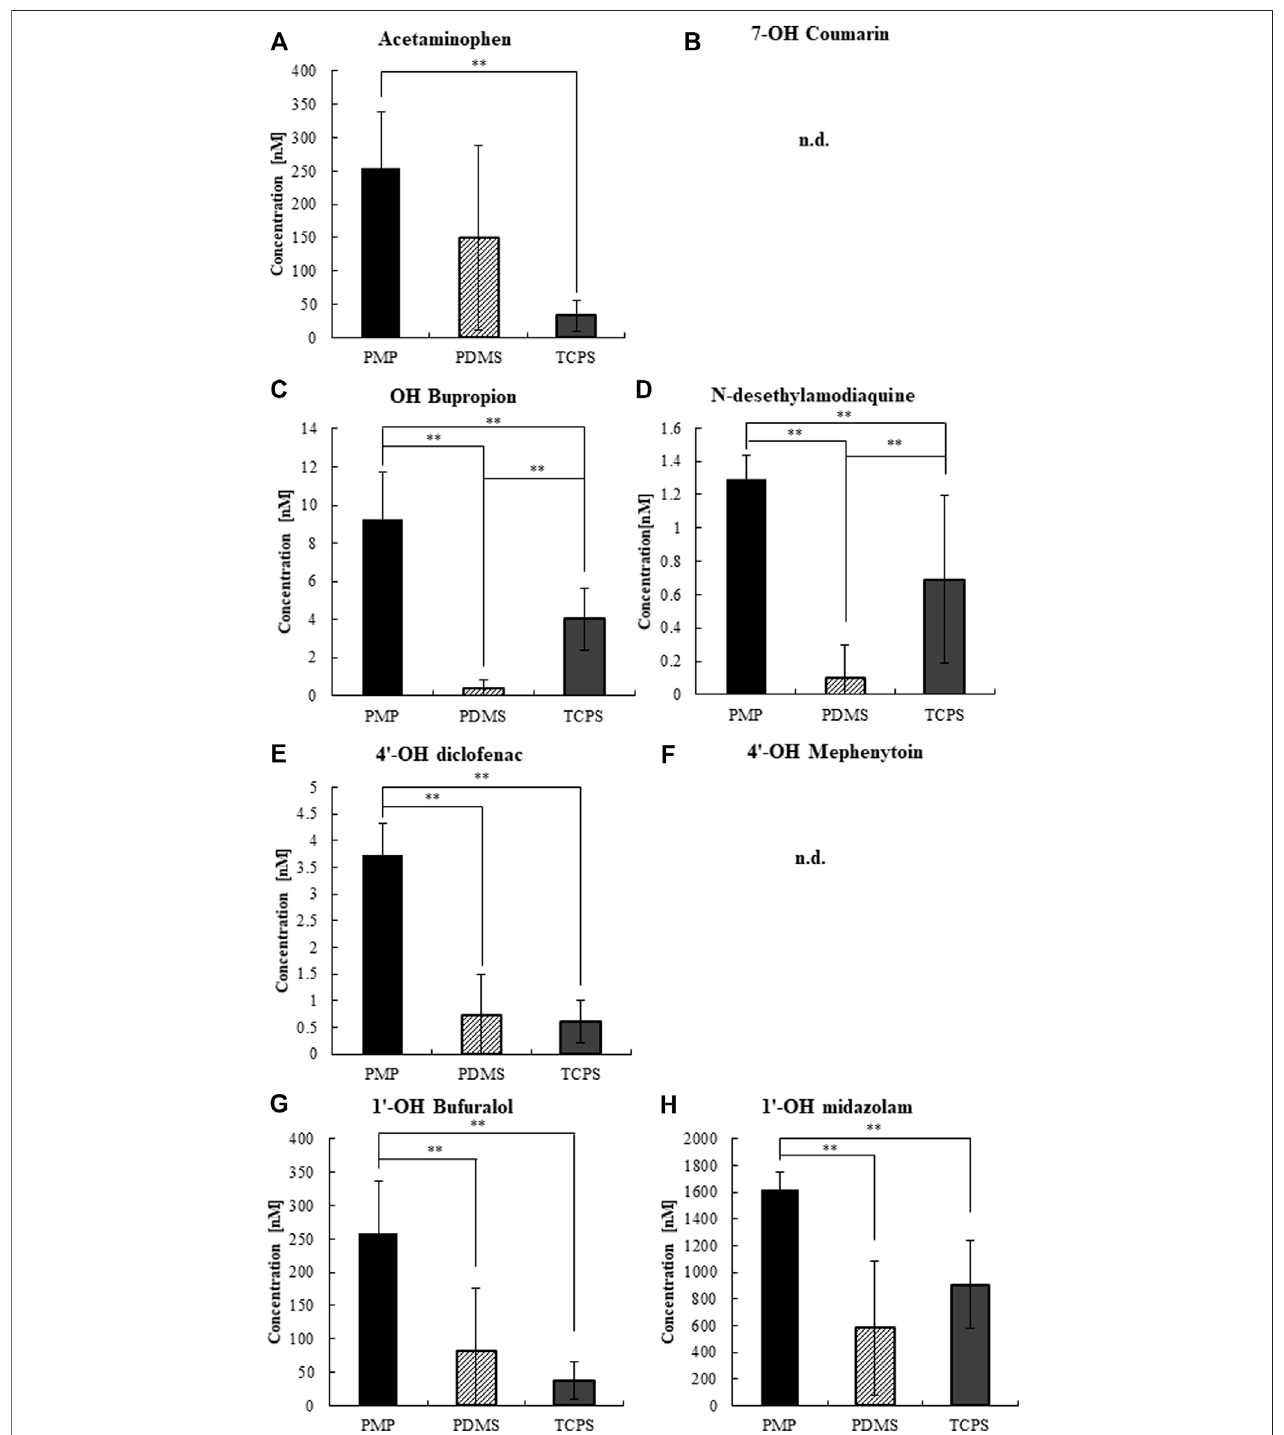
FIGURE 8 | The concentrations of CYP metabolites at 4 h of substrate exposure to cultured hepatocytes on day 7. (A) CYP1A2, (B) CYP2A6, (C) CYP2B6, (D) CYP2C8, (E) CYP2C9, (F) CYP2C19, (G) CYP2D6, and (H) CYP3A2 (N = 8).